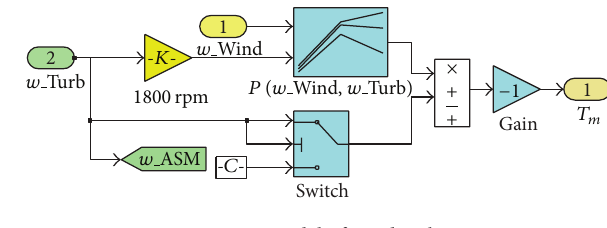
Figure 11: Model of wind turbine.